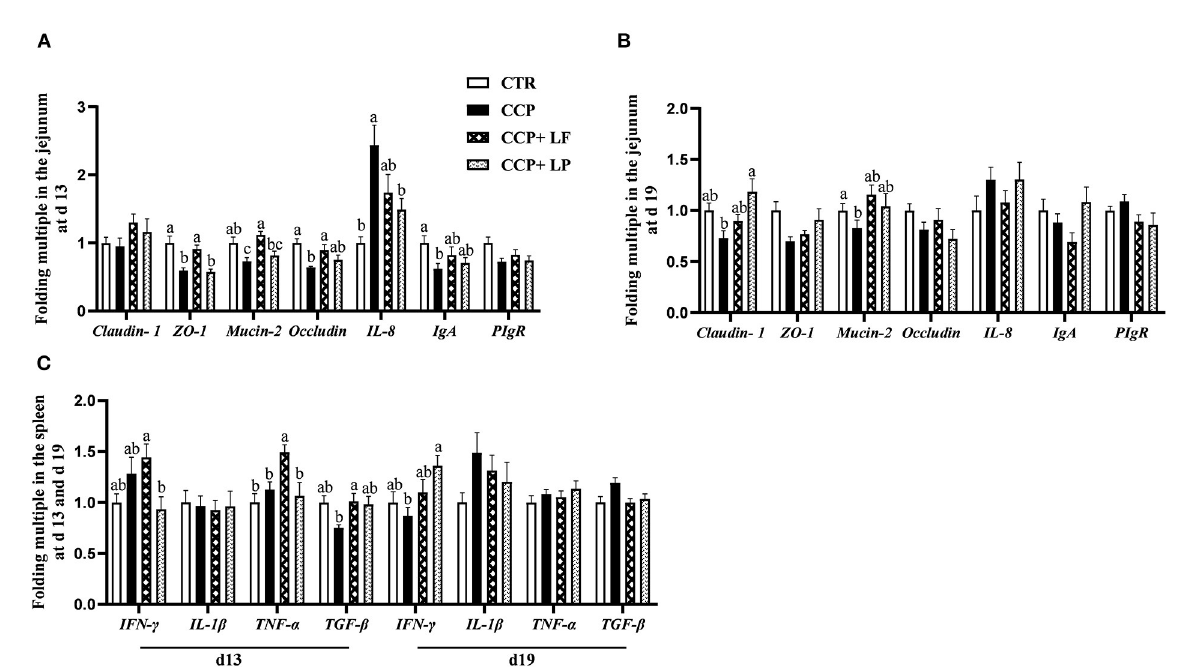
FIGURE4 The mRNA transcript levels of some genes in the jejunum and spleen. (A) The data of the gene mRNA levels in the jejunum on day 13, (B) the data of the gene mRNA levels in the jejunum on day 19, and (C) the data of the gene mRNA levels in the spleen. Among them, a,b, and c means in the different pillars without common superscripts differ significantly ( P < 0.05). n = 12. Data were presented as mean ± standard error. CTR, the control group; CCP, the group coinfected with coccidia and C. perfringens (CCP), CCP + LF and CCP + LP denote the groups fed Lactobacillus fermentum - and Lactobacillus paracasei -supplemented diets with CCP